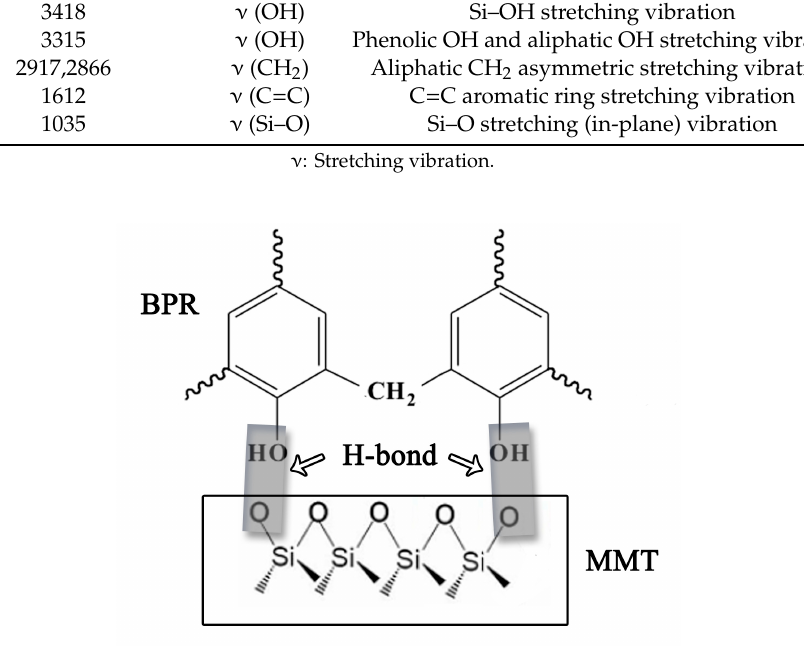
Figure 2. Schematic of hydrogen bond formation between BPR and MMT.